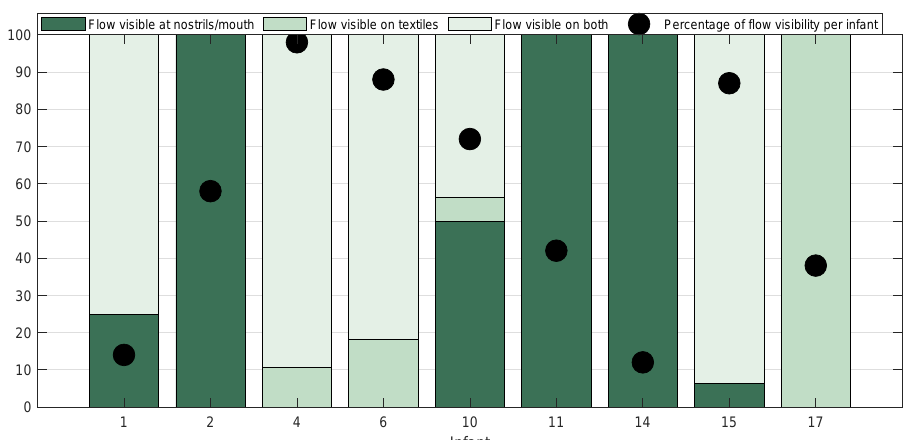
Figure 3. Information on the location of the annotated RF pixels for each infant and the percentage per infant of segments with flow visible compared to the segments annotated as still for at least 30 s.